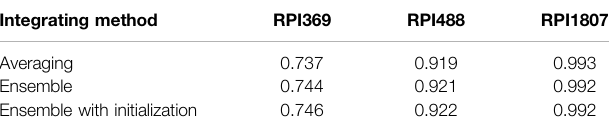
TABLE 4 | AUC of different integrating methods on three datasets. Integrating method